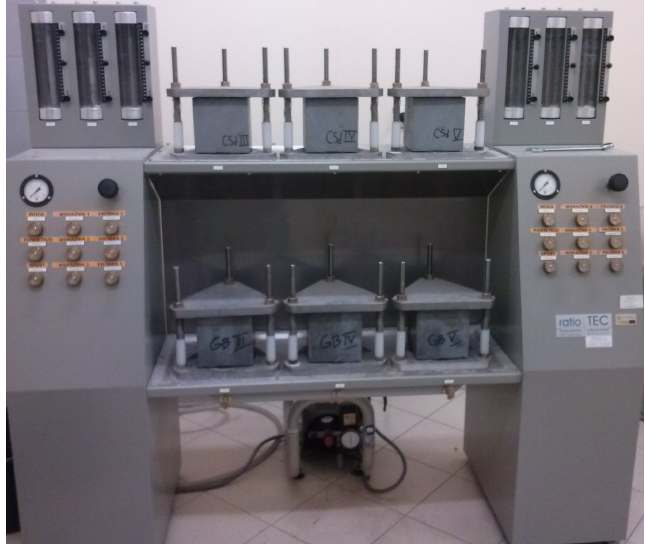
Figure 11. Samples during watertightness test.